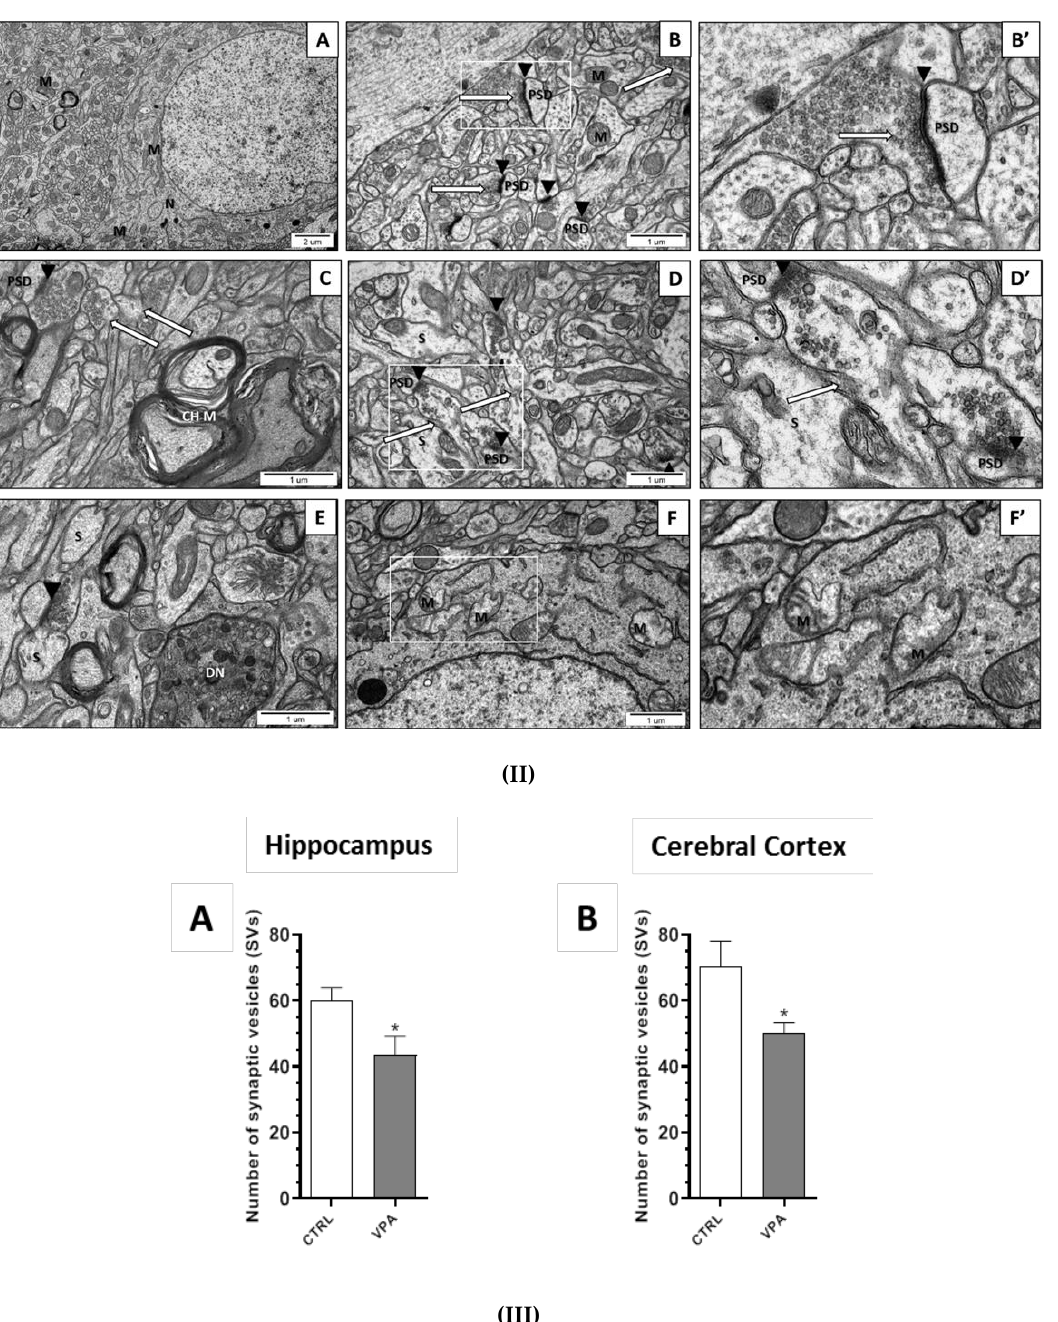
Figure 2. I . The effect of prenatal exposure to VPA on the ultrastructure of neuronal cells in the CA1 region of the hippocampus of the offspring. ( A – B’ ) Control group. Ultrastructurally unchanged neuronal cells, unaltered structure of neuropil with normal appearance of the synaptic cleft (black arrowheads), well-defined structure of the synapses with accurate postsynaptic density (PSD), the correct distribution of synaptic vesicles (SVs) (long arrows), and ultrastructurally unchanged mitochondria (M). ( C–G ) VPA-exposed group. Reduced packing density of SVs in the presynaptic area (release of SVs from the presynaptic area accompanied by disruption of the synaptic membranes) (long arrow), nerve ending swelling (S), blurred and thickened structure of the synaptic cleft without clearly marked pre- and postsynaptic membranes (black arrowheads). Ultrastructurally changed mitochondria with a blurred cristae structure (M). Astrocytes with features of swelling (SA) and